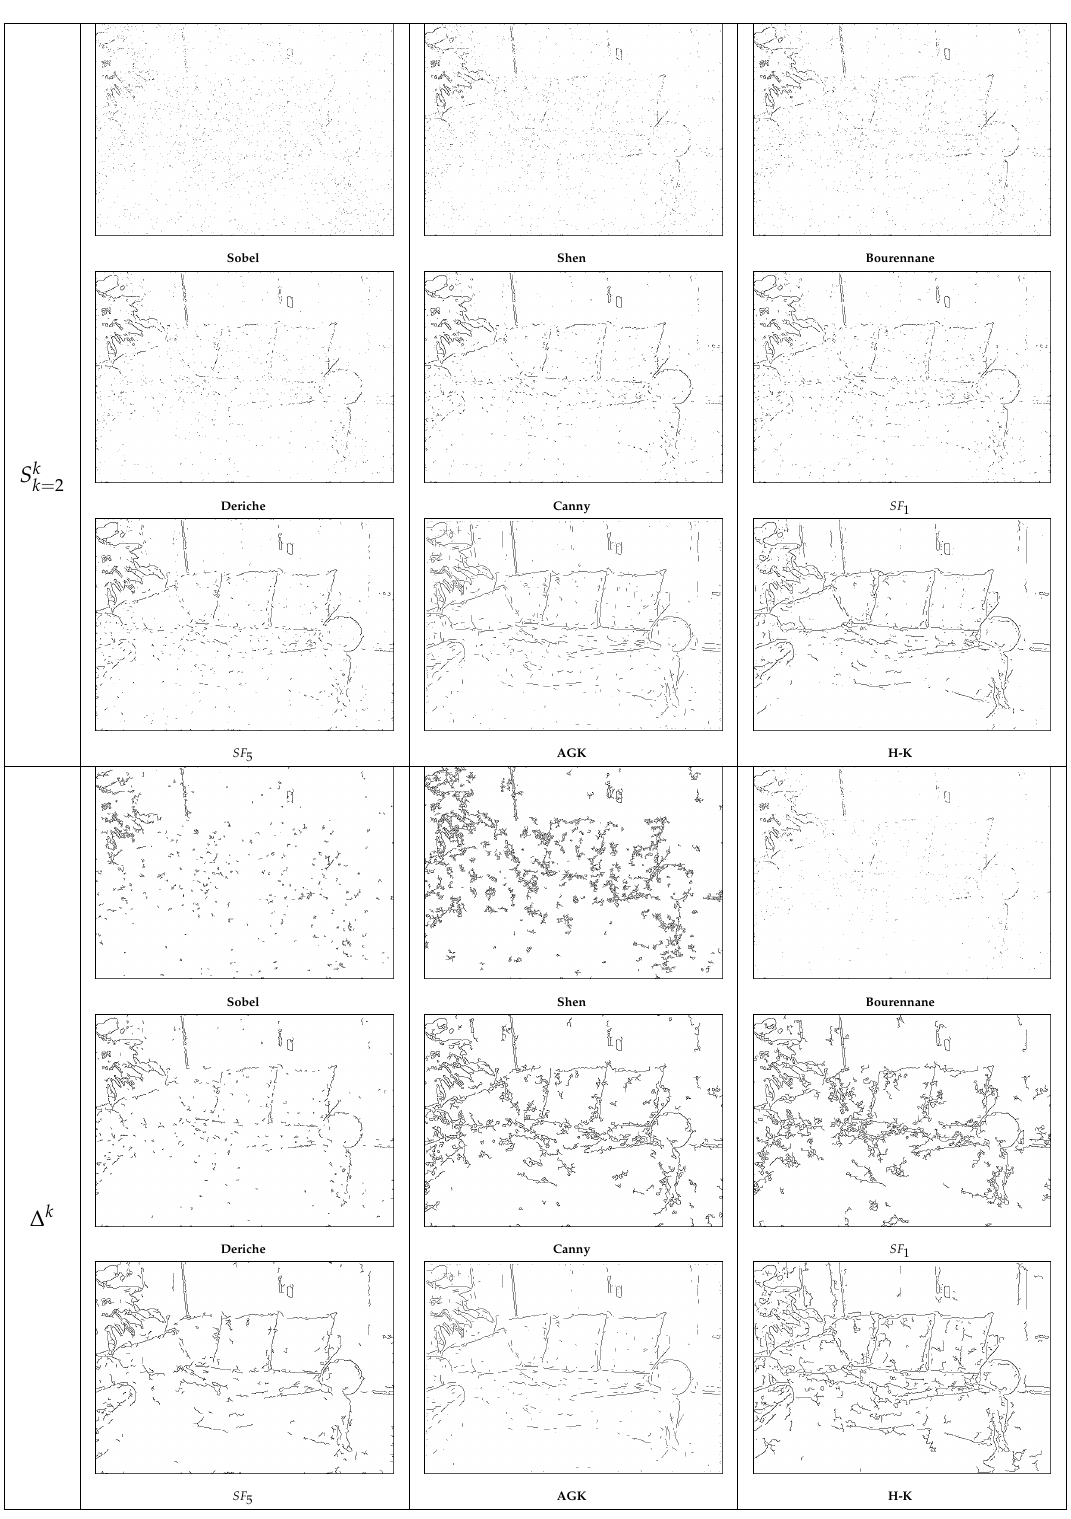
Figure 32. Ideal segmentations for several edge detectors on image 109, PSNR = 14